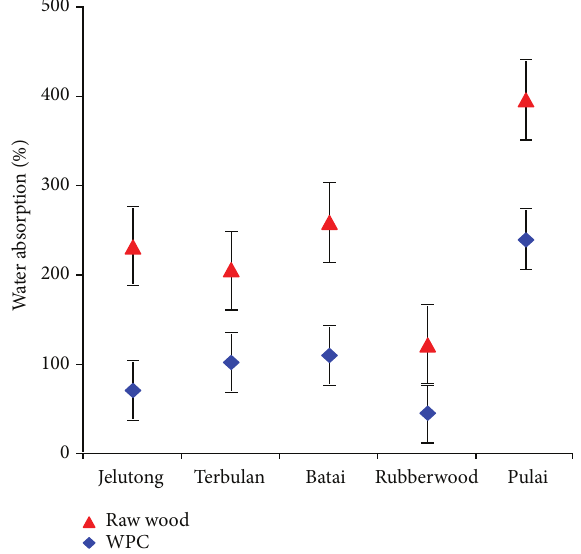
Figure 6: Average water absorption (%) of raw wood and WPC samples.